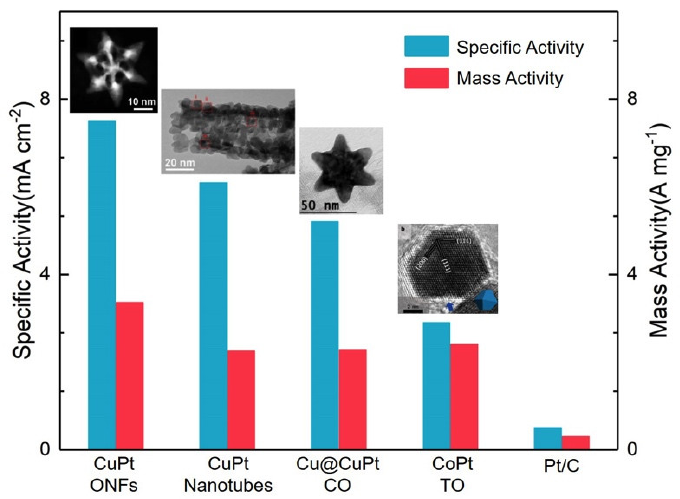
Figure 12. Comparison of various type of MOR Pt alloyed nanocatalysts that are reported in recent two years, including concaved CuPt ONFs [107], CuPt nanotubes [68], Cu@CuPt CO [106], CoPt TO [105], and 40% Pt/C [105]. Inset images, from left to right, were reprinted with permission